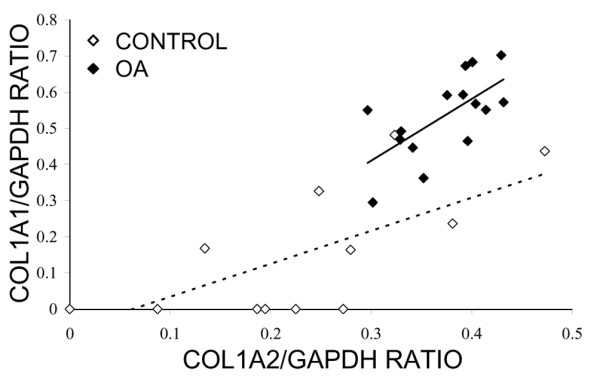
Association between the relative ratios of COL1A1/GAPDH mRNA and COL1A2/GAPDH mRNA. Gene expression was determined in intertrochanteric trabecular bone from patients with osteoarthritis (OA) (n = 15) and controls (n = 13). A significant correlation was observed between the two parameters in patients with OA (COL1A1/GAPDH = 1.71 [COL1A2/GAPDH] – 0.10; r = 0.66, p < 0.008) and controls (COL1A1/GAPDH = 0.91 [COL1A2/GAPDH] – 0.06; r = 0.70, p < 0.008). COL1A, collagen type I alpha chain; GAPDH, glyceraldehyde-3-phosphate dehydrogenase.